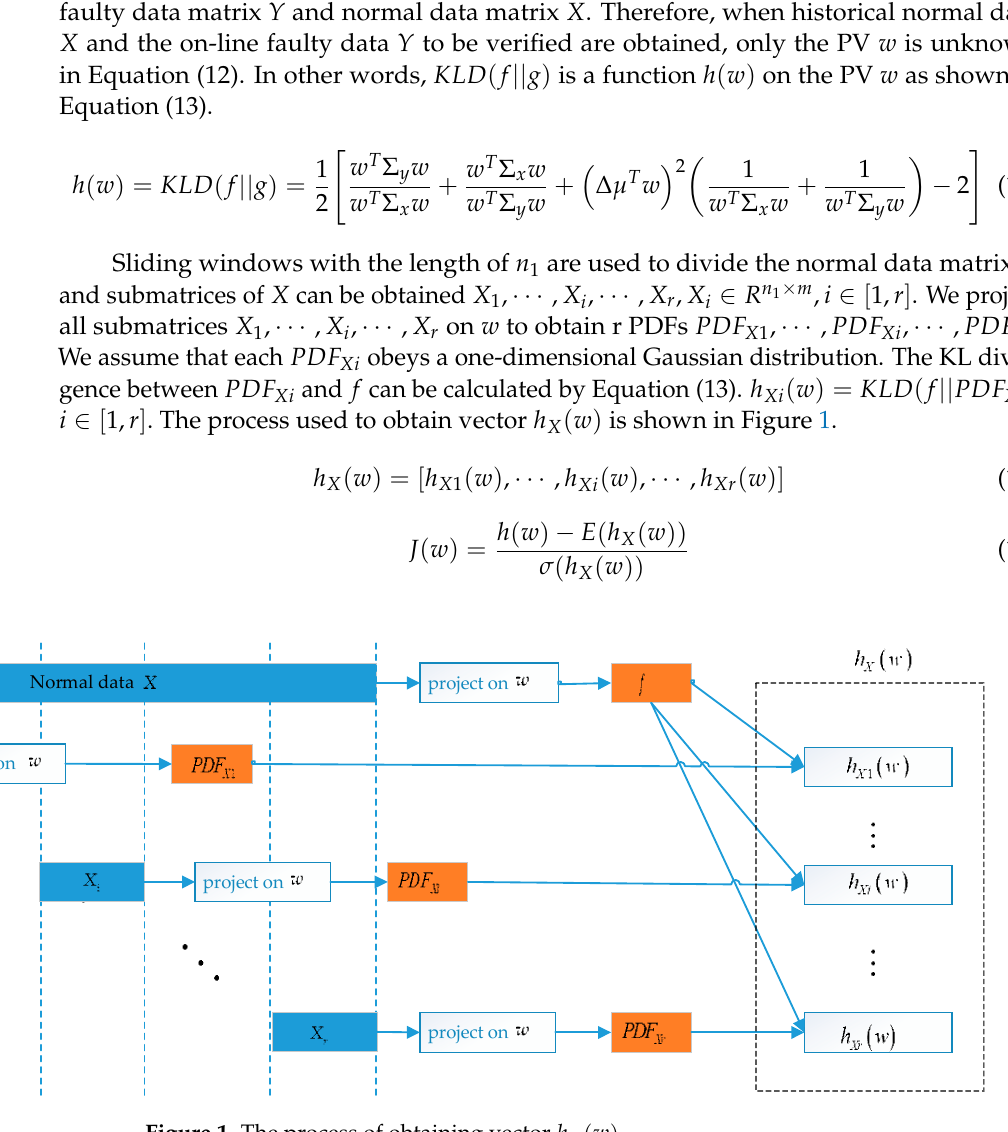
( ) Figure 1. The process of obtaining vector h w . Figure 1. The process of obtaining vector h X ( w ) . X data matrix X on the PV w is defined as shown in Equation (15). E ( h X ( w )) and σ ( h X ( w )) in Equation (15) are the mean and standard deviation of the vector h X ( w ) . E ( h X ( w )) and σ ( h X ( w )) reflect the center and range of the interval of variation range of the KL divergence for normal data after projection on w , respectively. Once the on-line faulty data matrix Y and normal data matrix X are given, the KL relative deviation J ( w ) still remains as the function about w